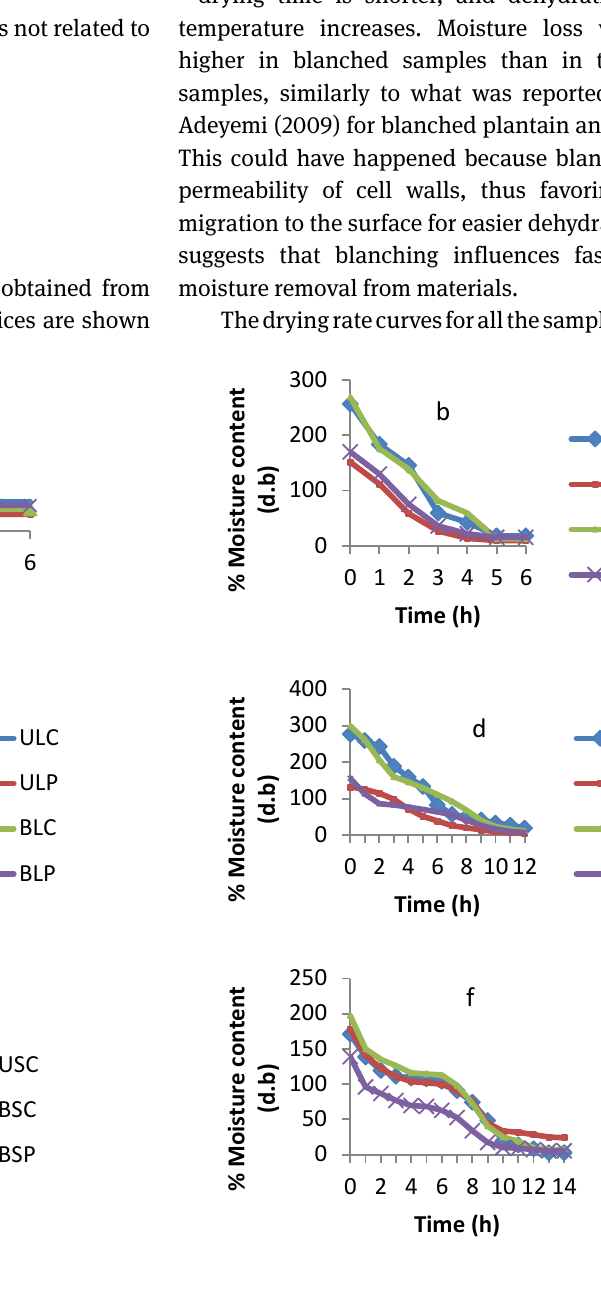
Figure 1: Percentage moisture content of blanched and unblanched cardaba and plantain on: a) wet basis dried at 70°C; b) dry basis dried at 70°C; c) wet basis dried at 50°C; d) dry basis dried at 50°C; e) wet basis sun-dried; f)